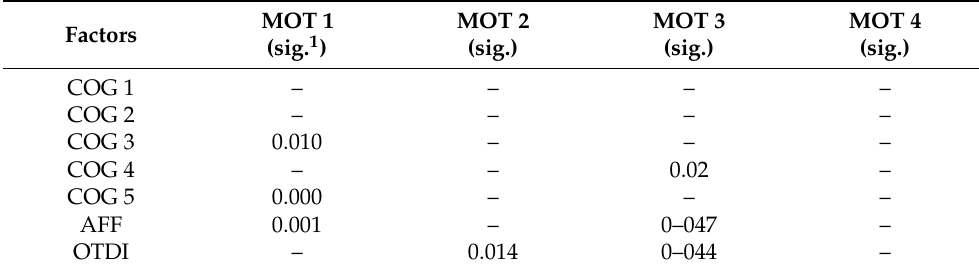
Table 6. Effects of MOTs on COGs, AFF and